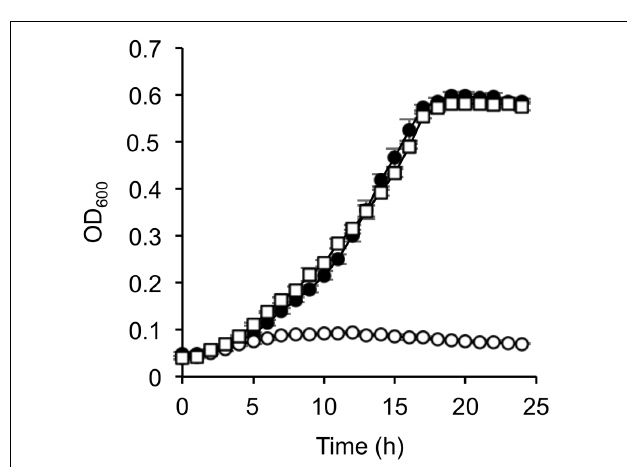
FIGURE 4 | Quantitative RT-PCR (qRT-PCR) analyses of lldP , dld , and lldF in WT (gray bars) and (cid:49) crp (white bars). Cells were aerobically grown in MM containing 10 mM DL -lactate and harvested in the logarithmic growth phase. Results are expressed as relative values to mRNA levels in the WT cells. Error bars represent standard deviations calculated from at least three independent experiments.